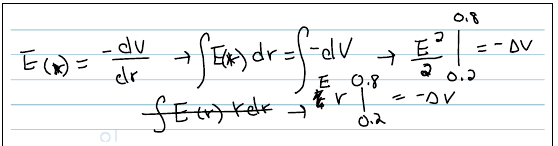
FIG. 9. Kara ’ s version of the analytical derivation game to solve the electrostatics